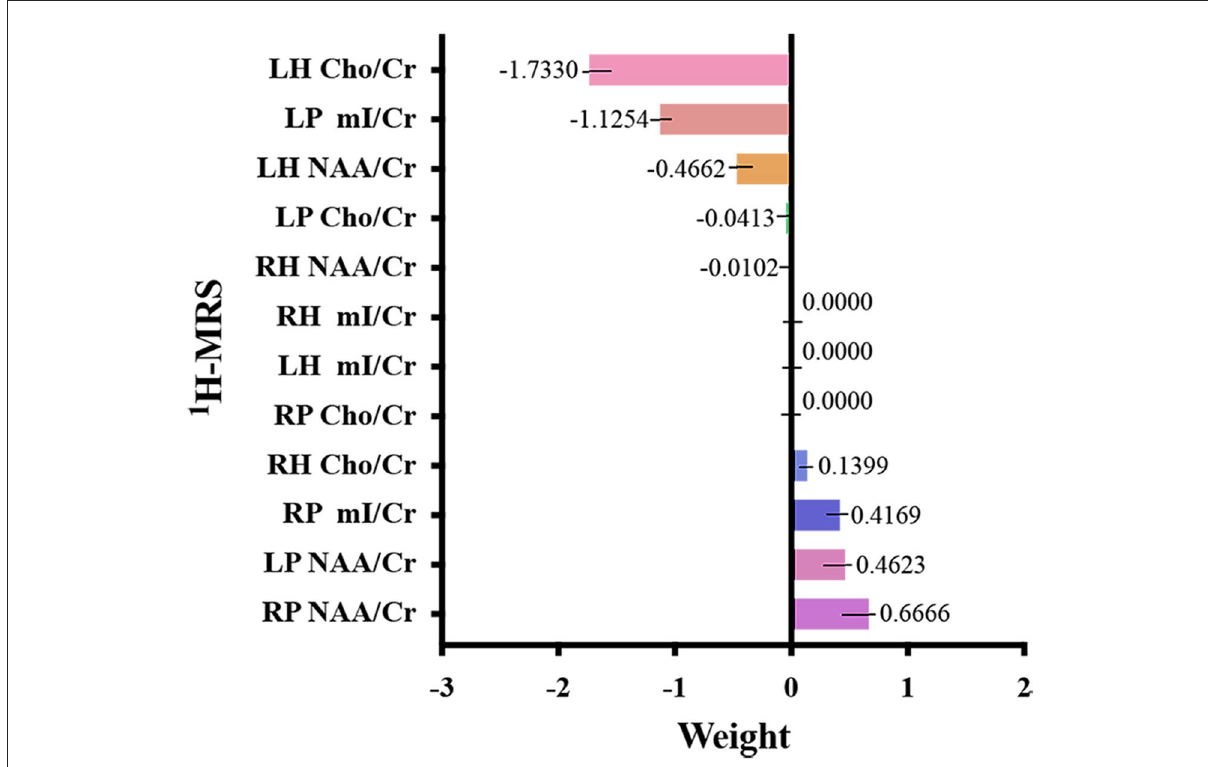
FIGURE5 Weight value of each feature corresponding to the highest classification accuracy (LH, left hippocampus; RH, right hippocampus; LP, left prefrontal whiter matter; RP, right prefrontal whiter matter; NAA, N-acetylaspartate; Cho, choline; mI, myo-inositol; Cr, creatine).